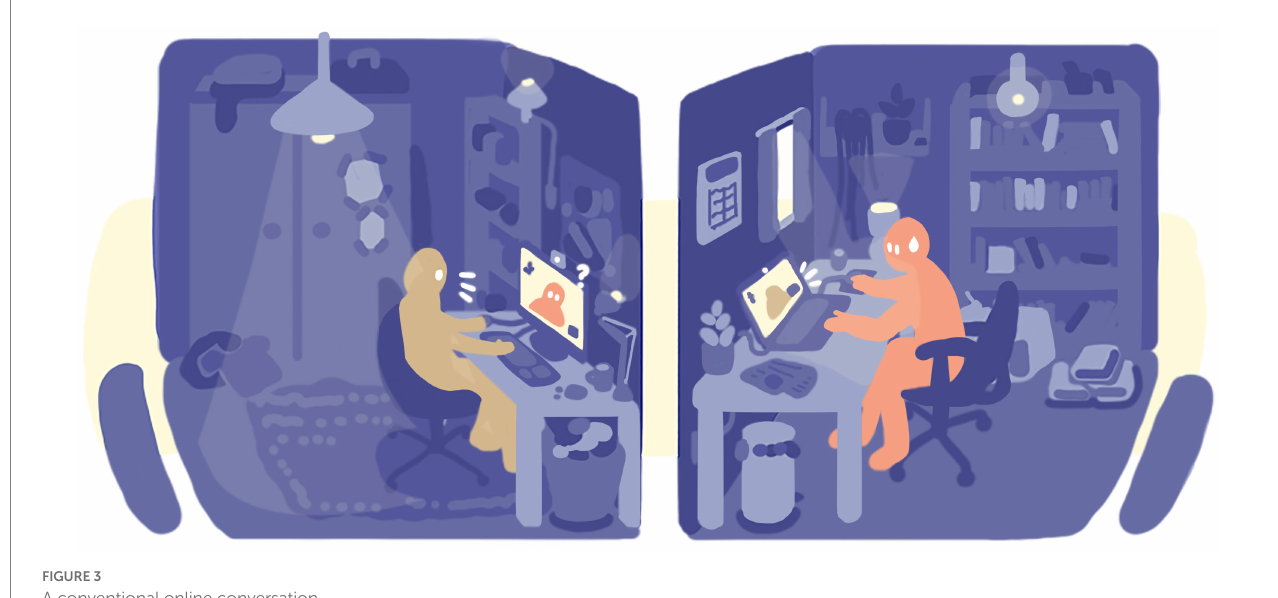
FIGURE 3 A conventional online conversation.